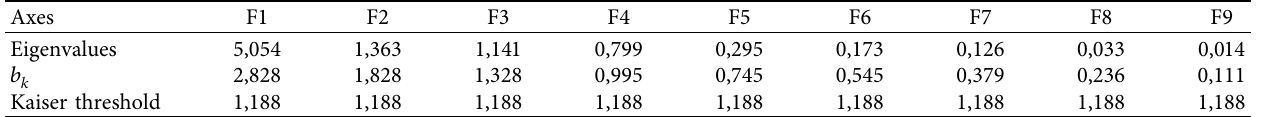
Table 8: Boundary values of the broken sticks test and the Kaiser